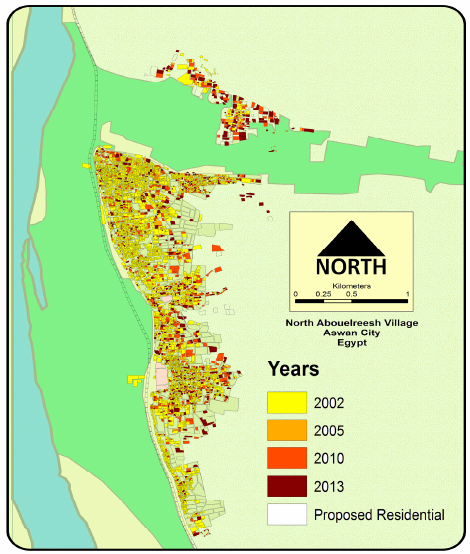
Figure 5. A map showing the current status of the village of Abouelreesh (with the years in which construction occurred designated according to color).